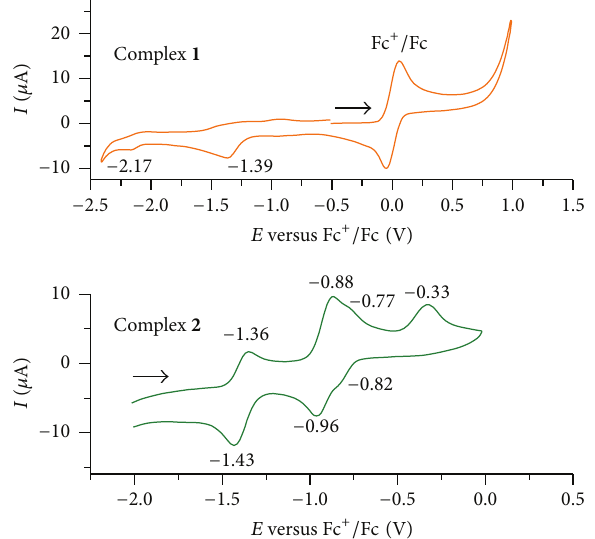
Figure 5: Cyclic voltammetry of complexes 1 and 2 in dimethylsul-